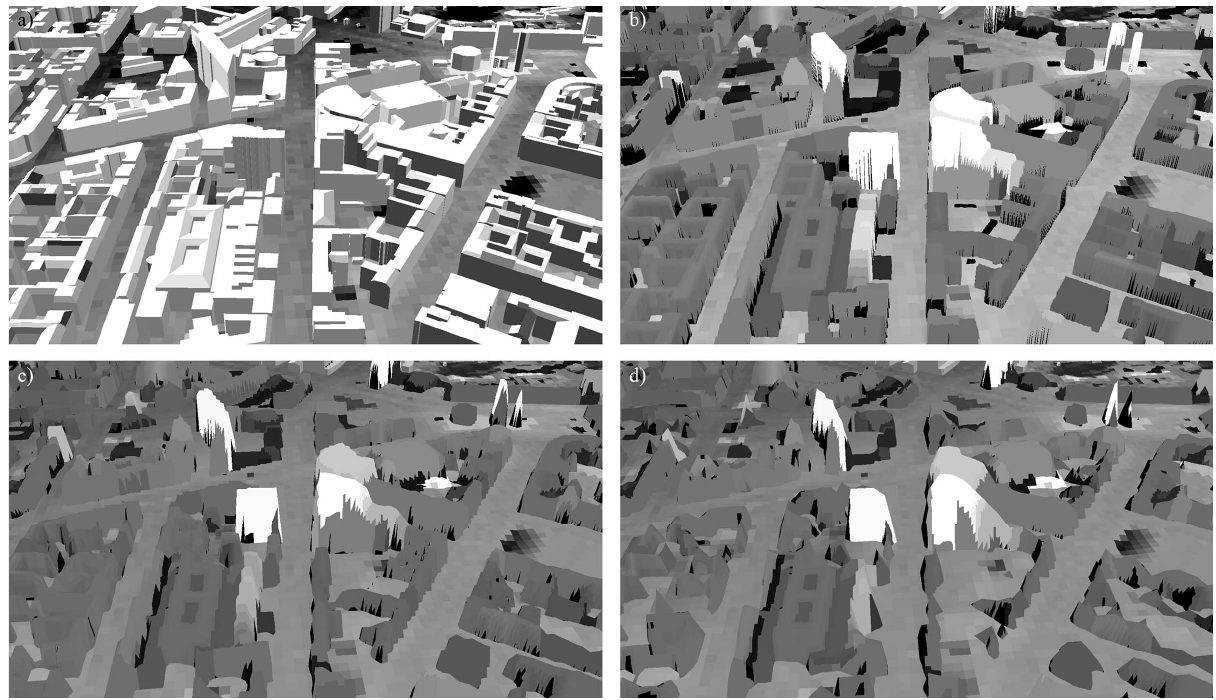
Figure 2. Comparison of Berlin model accuracy: a) base model in CityGML format; b) DSM model – cell size: 1m; c) DSM – cell size: 5m; d) DSM – cell size: